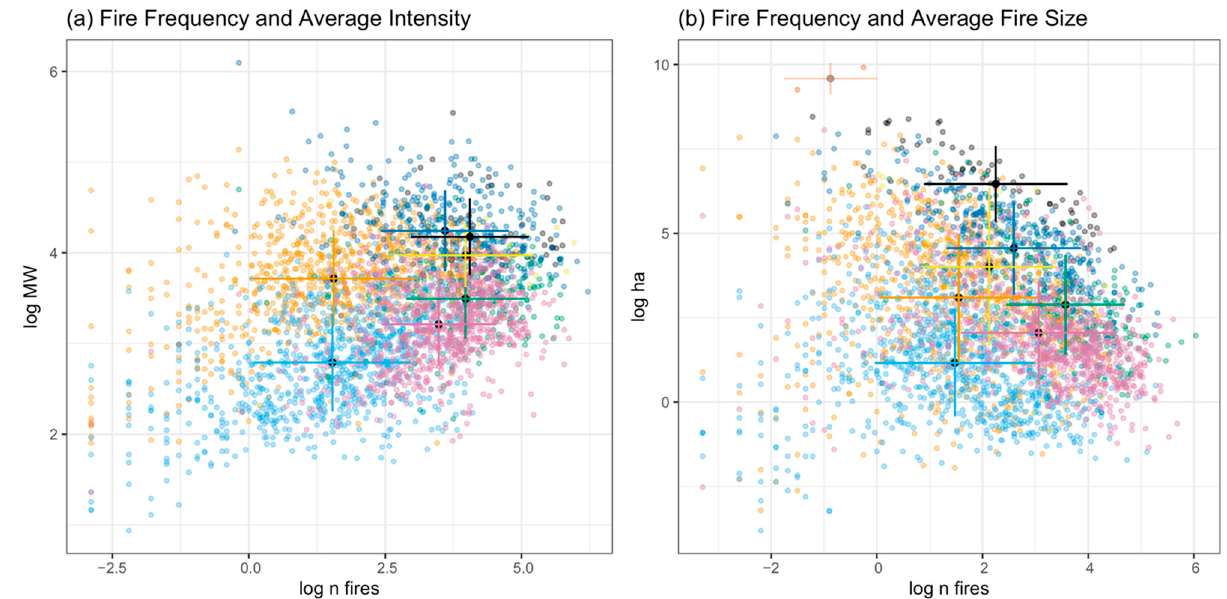
Figure 3. Relationships between fire physical characteristics in the contiguous U.S.: ( a ) frequency and intensity (number of fires and mean fire radiative power (FRP), megawatts (MW) from the Moderate Resolution Imaging Spectroradiometer (MODIS)) and ( b ) frequency and size (number of fires and mean fire event size, hectares (ha) from the Fire Program Analysis fire-occurrence database (FPA-FOD)). All values are log-transformed annual pixel means.